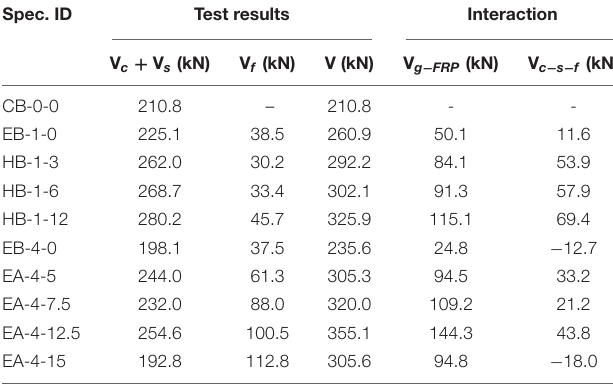
TABLE 4 | Interaction between shear strength components. Spec.